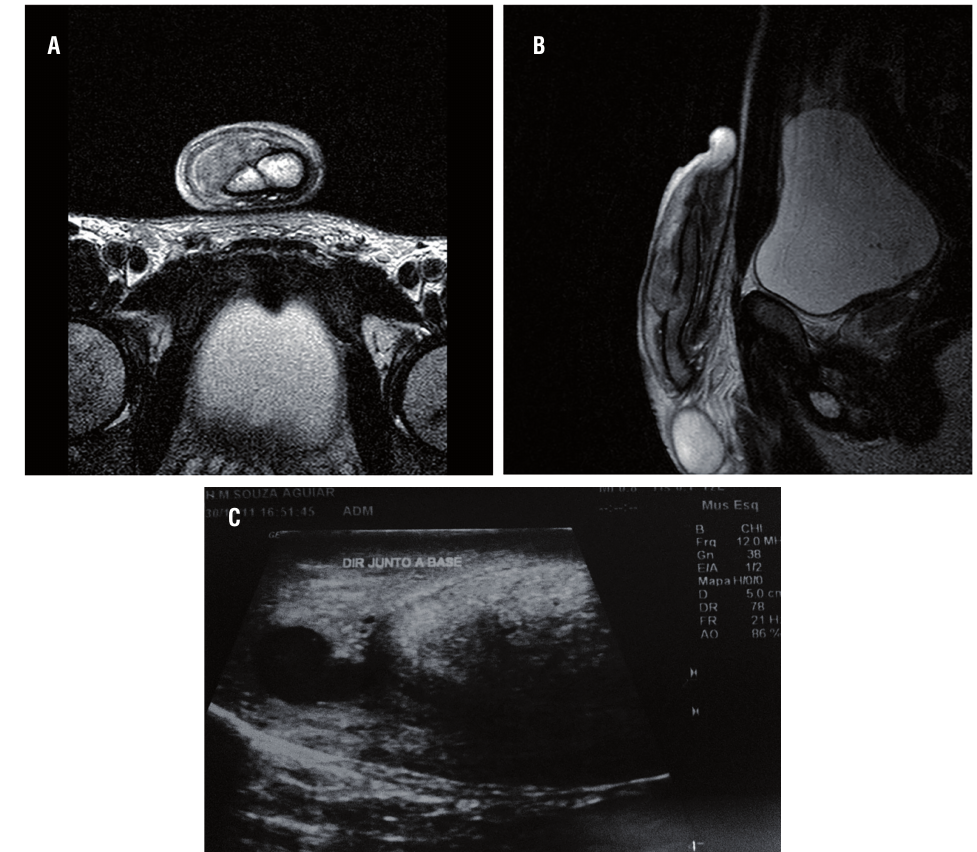
Figure 4 - Patient with doubtful clinical picture of PF submitted to penile MRI demonstrating right corpus cavernosum base rupture with moderate hematoma in axial and sagittal images (A+B). Ultrasound demonstrating right corpus cavernosum base rupture with mild hematoma in another patient with doubtful clinical picture of PF